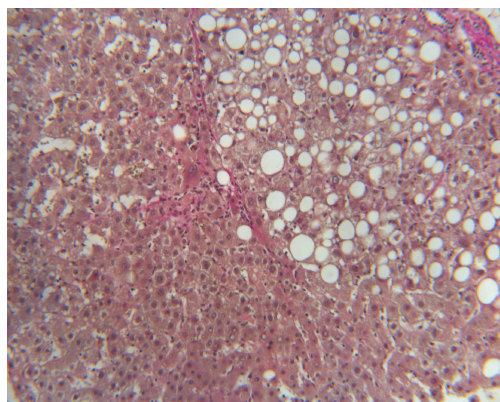
Figure 1: Initial nodular regenerative hyperplasia of the liver with localised fatty